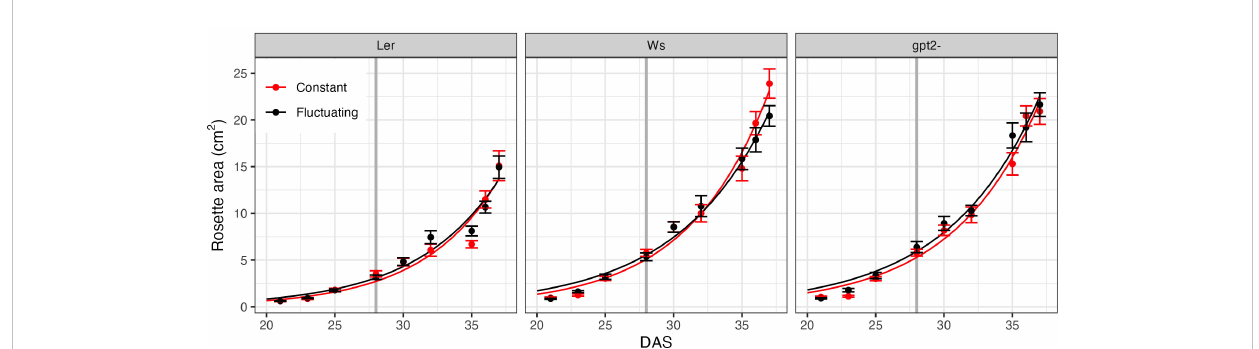
FIGURE 2 Rosette area time course. Measurements began 21 days after sowing (DAS) for constant light (red) and fl uctuating light (black) plants. Each data point correspond to n =4 replicates. For the fl uctuating light treatment plants, the light pattern was changed at 28 DAS, as denoted by the grey vertical line. Curves show fi tted exponential growth given by Eq.